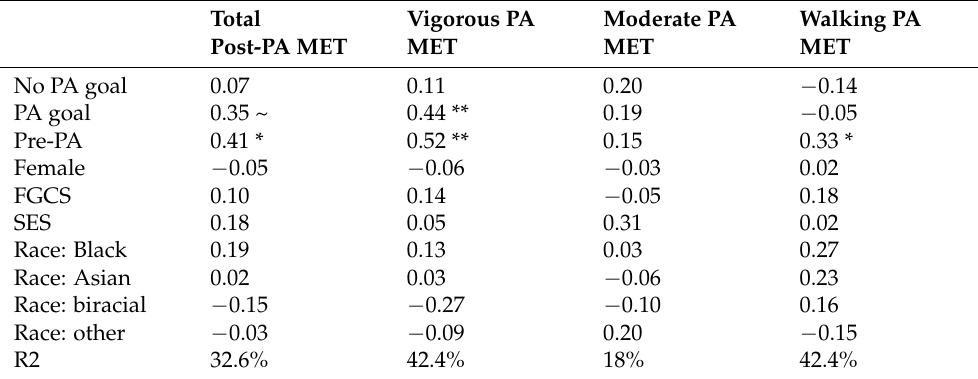
Table 4. Regression analysis on post-PA parameters (n =